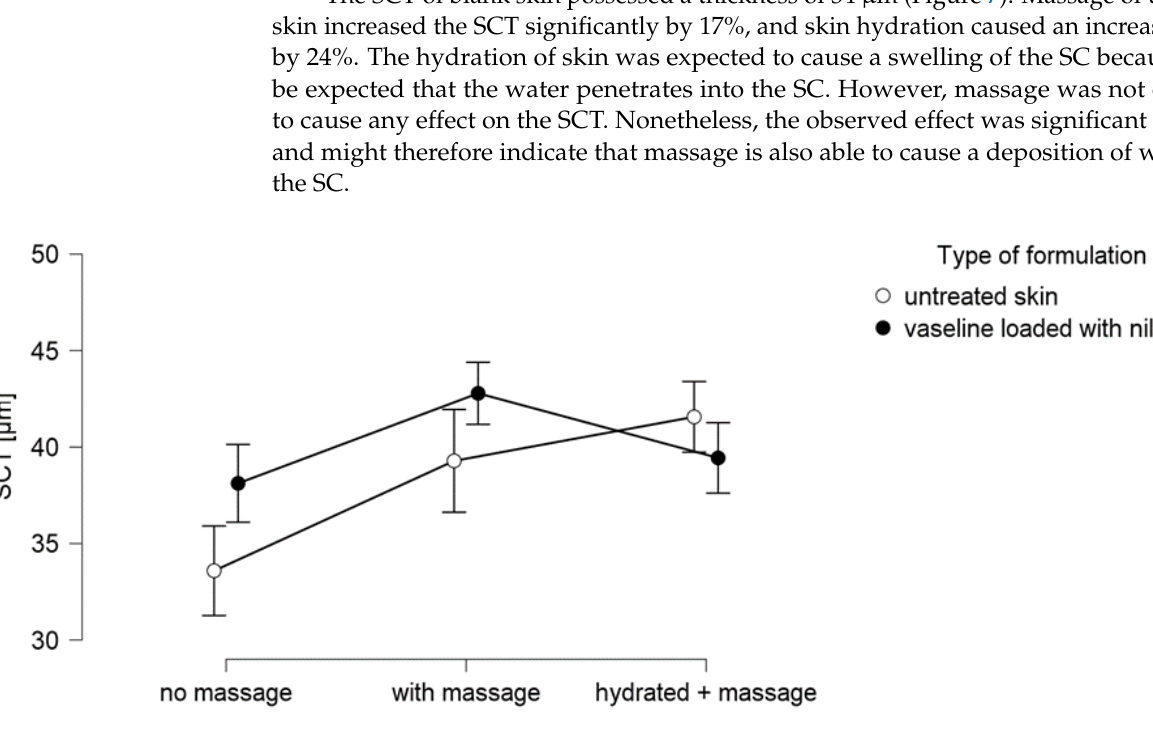
Figure 7. Influence of massage and skin hydration on the stratum corneum thickness (SCT).